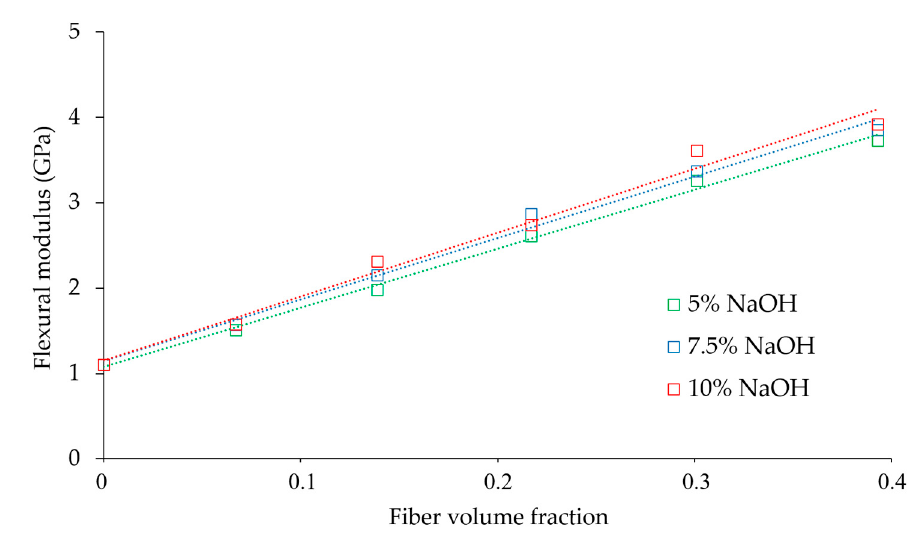
Figure 5. Evolution of the flexural modulus with the fiber volume fraction.